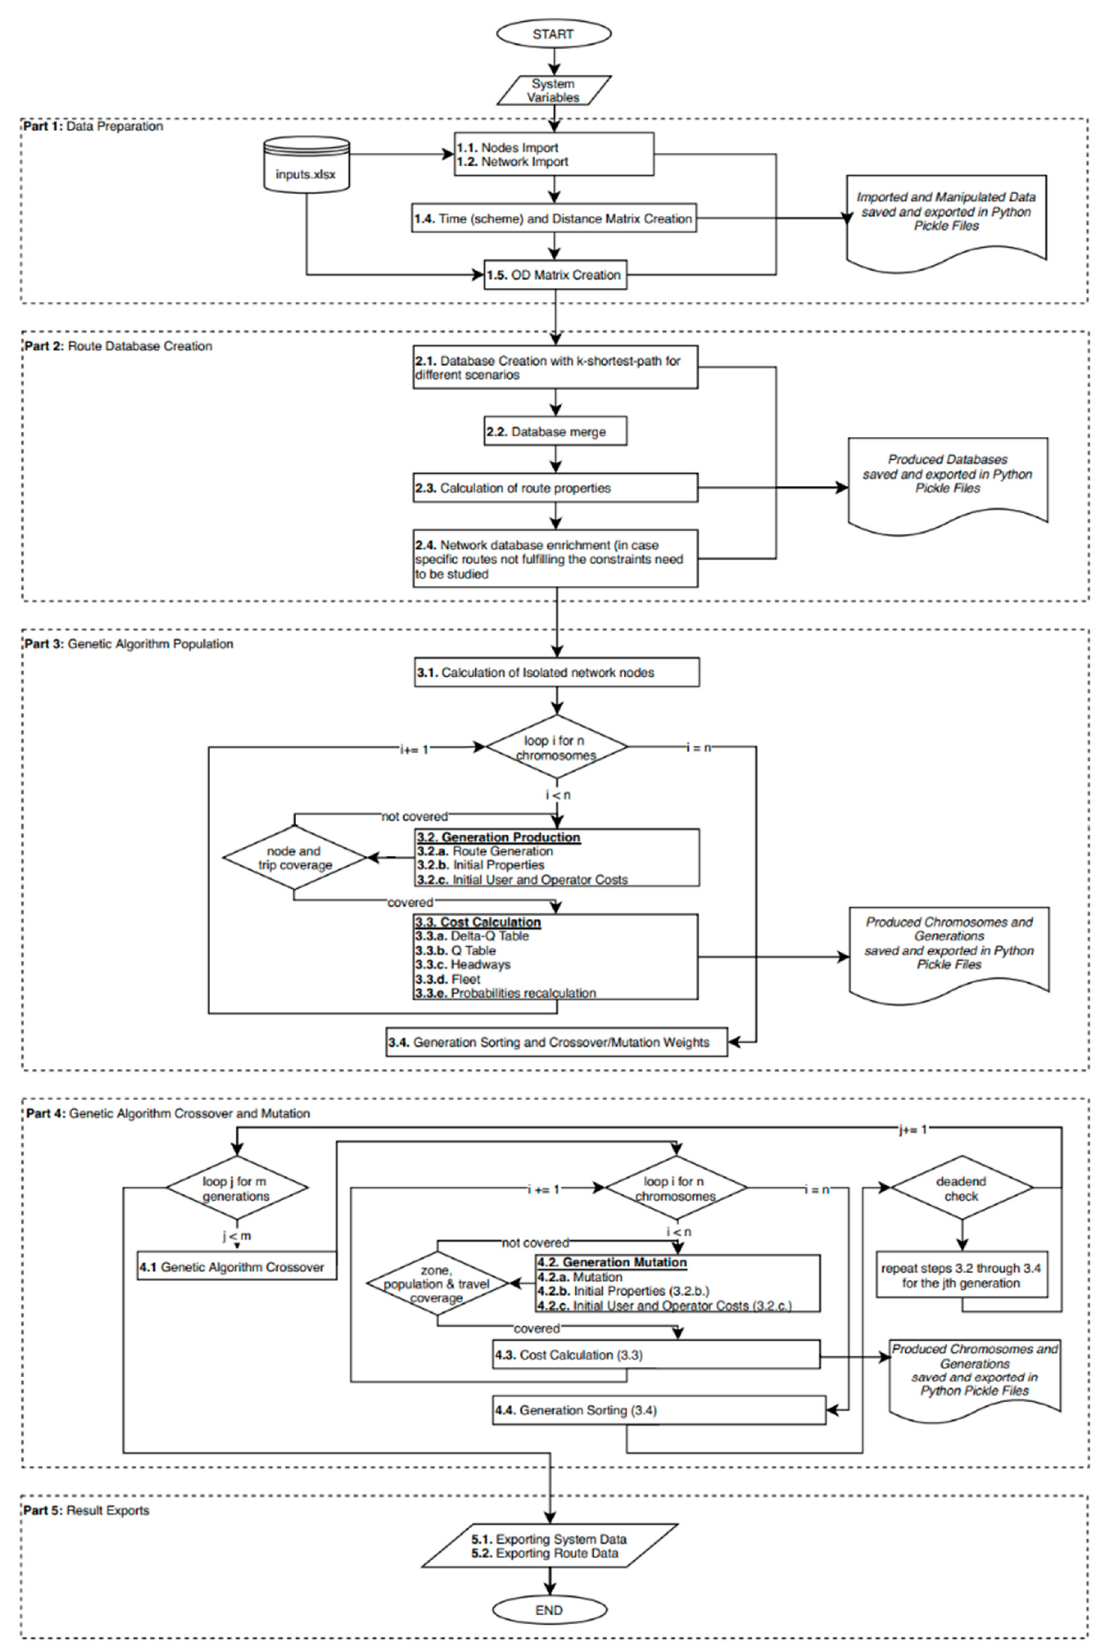
Figure 1. Alternating-Objective Genetic Algorithm flowchart.